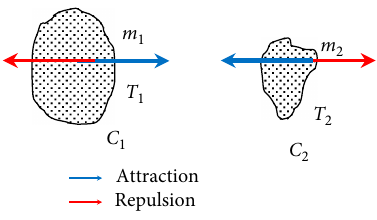
Figure 4: Forces acting in between two arbitrary particles with masses 𝑚 , 𝑚 , temperatures 𝑇 1 2 . There exist attraction (blue arrows) and repulsion forces (red 𝐶 , 𝐶 1 2 arrows) between